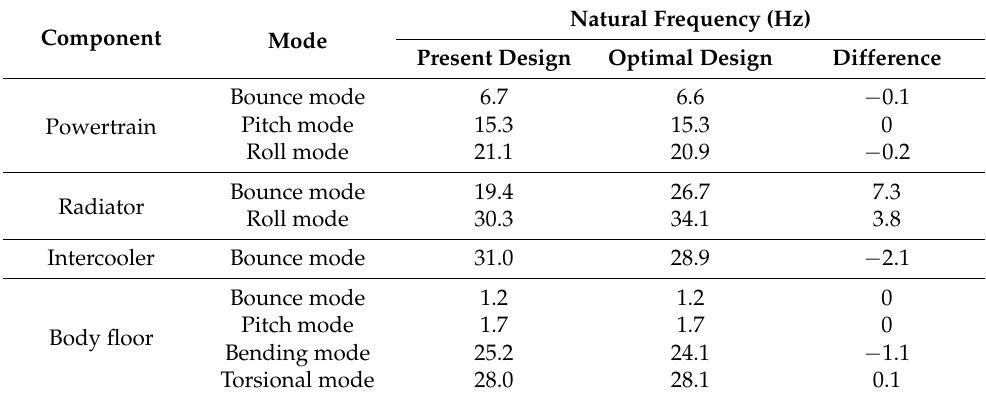
Table 5. Comparison of the natural frequencies for the present and optimal designs.